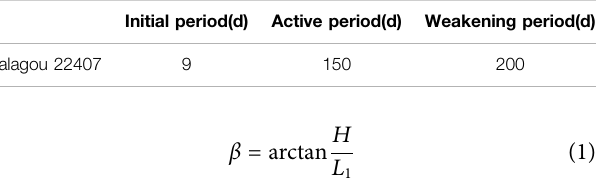
TABLE 2 | Duration of each movement period.